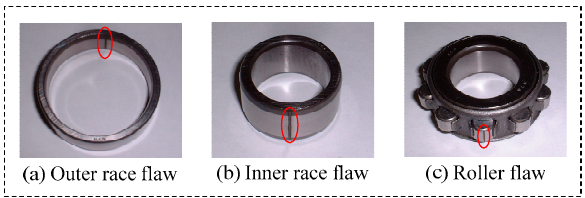
Figure 15. Bearing flaw of outer race, inner race and roller. Table 5. Fault characteristic frequency of inner race fault, outer race fault and roller fault.